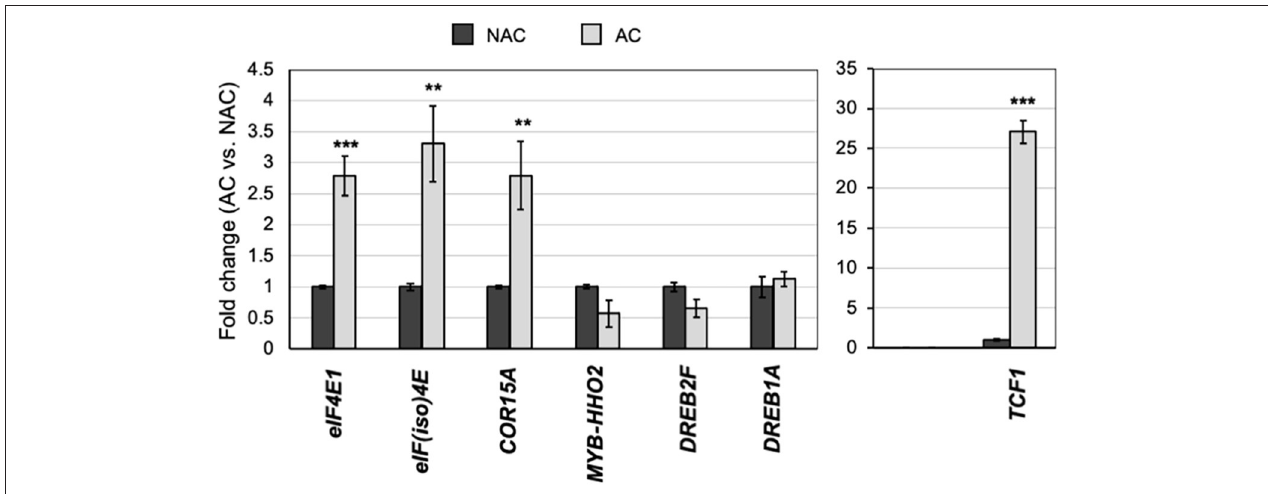
FIGURE 4 | Expression of stress-responsive genes upon cold acclimation in wild-type Col-0 plants. Transcript levels of selected stress-responsive genes (see Supplementary Figure 4 ), eIF4E1, and eIF(iso)4E were analyzed by RT-qPCR in acclimated (AC; gray bars) and non-acclimated (NAC; black bars) 8-week-old adult plants grown under short photoperiod. Actin was used as reference control and plotted values represent the expression of each mRNA relative to NAC. Three independent replicates were analyzed. Student’s t -test was used to evaluate statistically significant differences: ** p < 0.01, *** p <